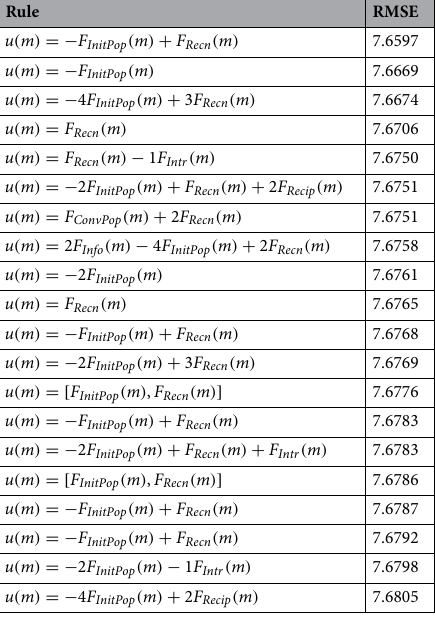
Table 1. Examples of rules that produced the lowest RMSE in responsiveness to the real-world data. The top 20 rules that resulted in the lowest RMSE are provided as examples of rules produced by the genetic program in evolutionary model discovery. Solutions for u ( m ) were evolved by combining the nine factors using the + , −, × , and ÷ operators. The presence value of a factor F i is considered as its coefficient in u ( m ). F Recn and F InitPop appear in most of the optimal solutions. (Square brackets indicate interactions between factors i.e. multiplication or